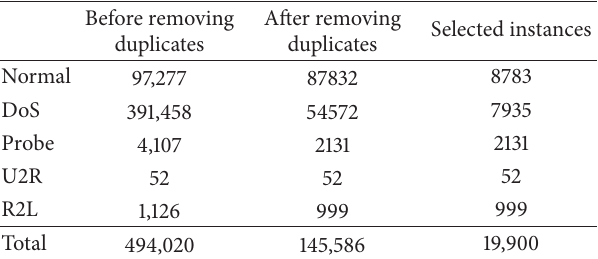
Table 4: Details of instances in the